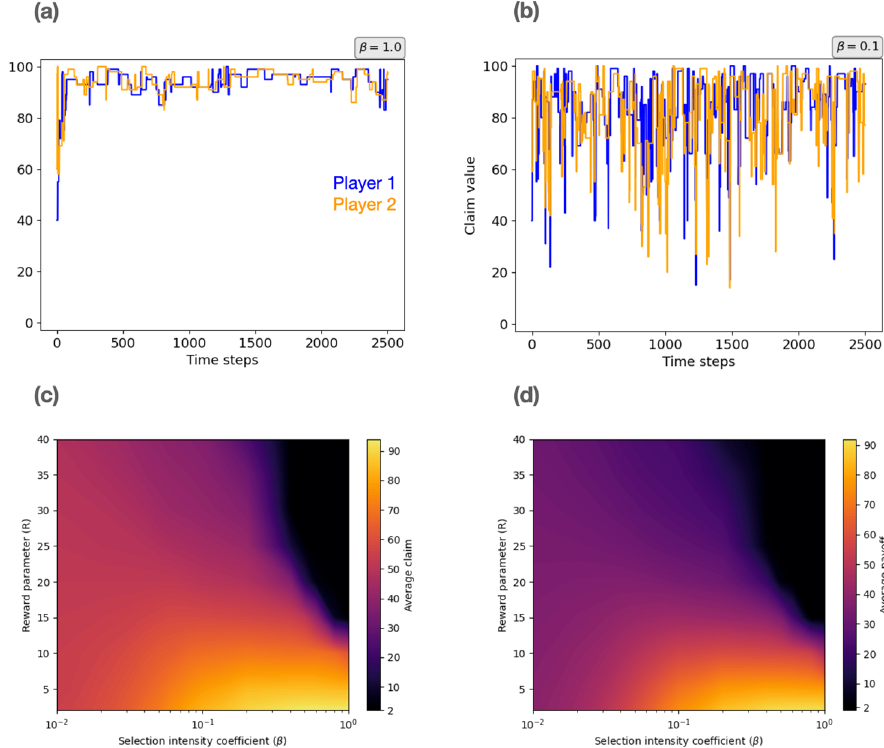
1.0 , Figure 4. Introspection dynamics for the Traveler’s Dilemma. Dynamics of the system for strong, ( a ) β = 0.1 , both for R 2 . For the strong selection regime, the system converges and weak selection intensity, ( b ) β = = to large claims thanks to the global optimisation process. In particular, the system oscillates in the high claim region, given that at a local level the system does not have a maximum. On the other hand, for weak selection the system becomes increasingly stochastic, until it fluctuates across all the action space. The stationary distribution of actions allows the analytical calculation of the ( c ) average claim and the ( d ) average payoff for different reward parameter ( R ) and selection intensity ( β ) values. It can be seen that strong selection and a low reward are needed for the convergence to high